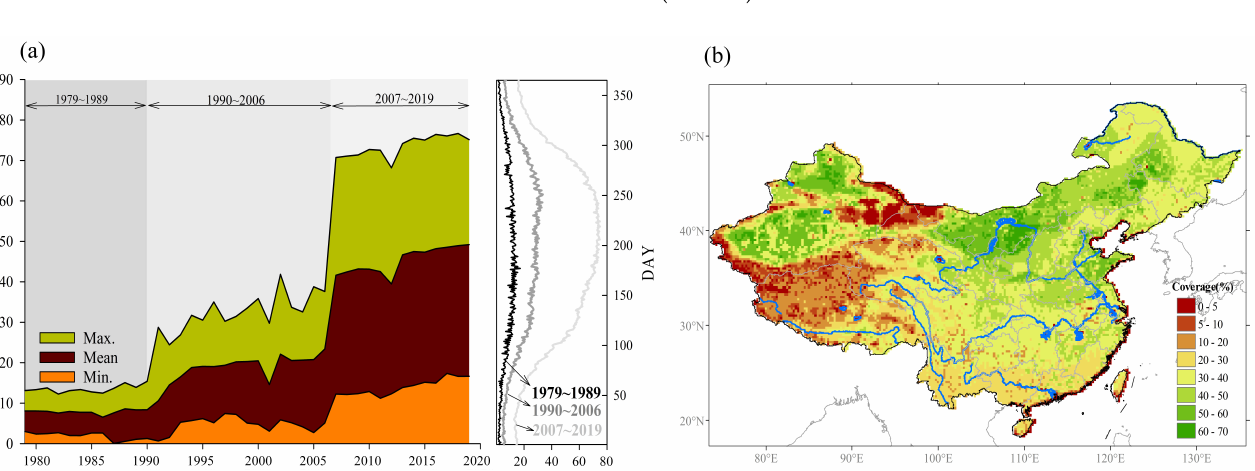
Figure 1. ( a ) Maximum, mean, and minimum coverage of available ESA CCI SM data in China and the distribution (i.e., the Days of Year (DOYs)) of data coverage over multiple years. ( b ) Fractional coverage of available data for each grid in China during 1979 −